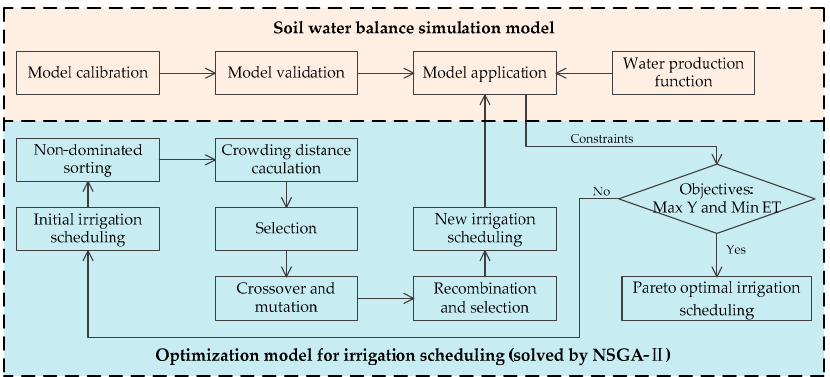
Figure 3. Framework of Simulation–Optimization Model for irrigation scheduling.